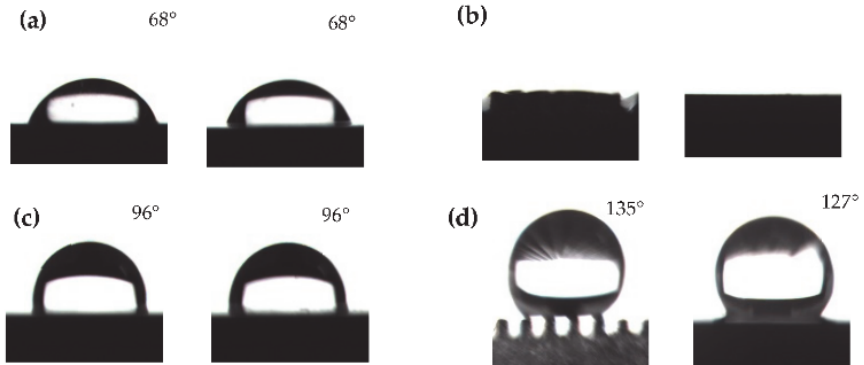
Figure 6. CA of smooth surface and macrostructure surface. ( a ) CA of unprocessed titanium alloy plate; ( b ) surface wettability of macrostructure; ( c ) CA of unmachined titanium alloy plate after low surface energy modification; ( d ) CA of titanium alloy plate with macrostructure after low surface energy modification.